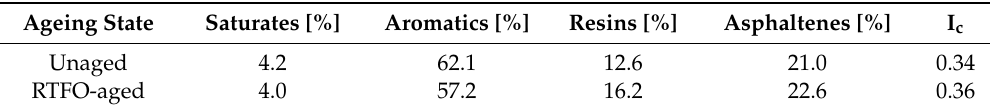
Table 3. Results of SARA analyses performed on neat bitumen.